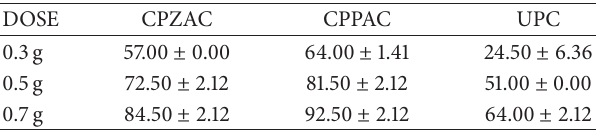
Table 3: The effect of different activation methods on surface (oxygen containing) functional groups of carbon